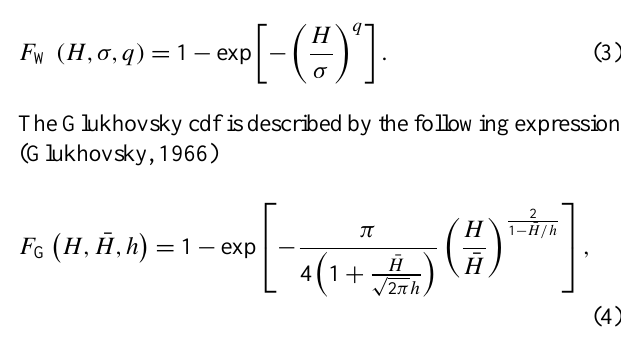
tion ( σ = 0 . 16m, q = 1 . 53) fitted using the maximum likelihood (  =0.16 m, q =1.53) fitted using the maximum likelihood estimate.